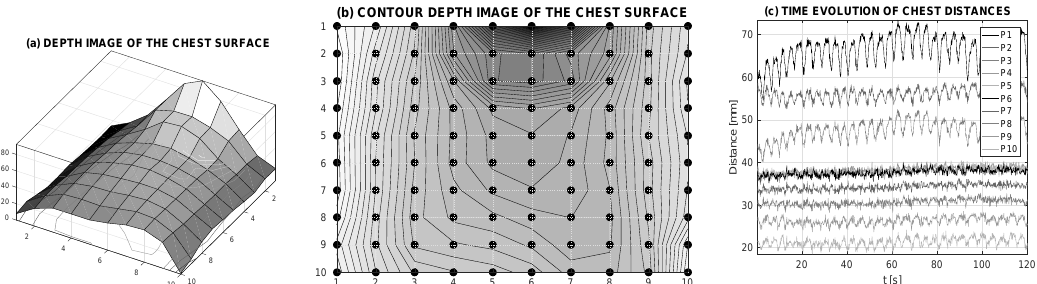
Figure 6. Mapping of chest movement recorded by the depth MS Kinect sensor presenting ( a ) the depth image of the chest surface in its selected area analysed on a grid with a resolution of 10 by 10 elements; ( b ) the contour depth image of the chest surface at the specified time; and ( c ) the time evolution of distances at the vertical axis of the mapped area during a 120 s data segment.